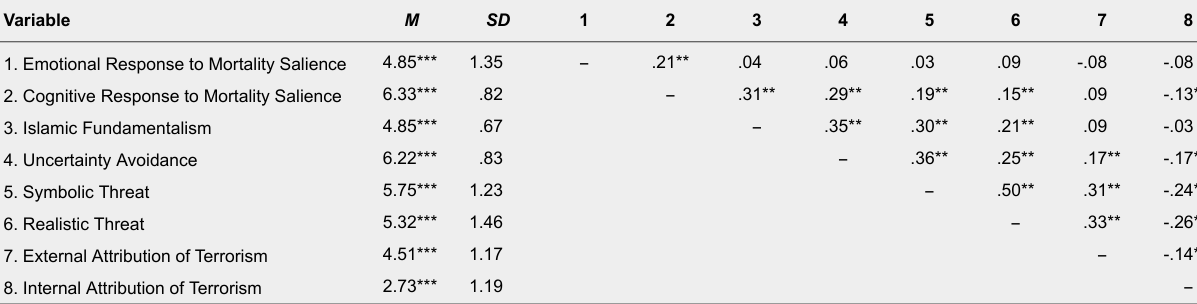
Correlations Among Observed